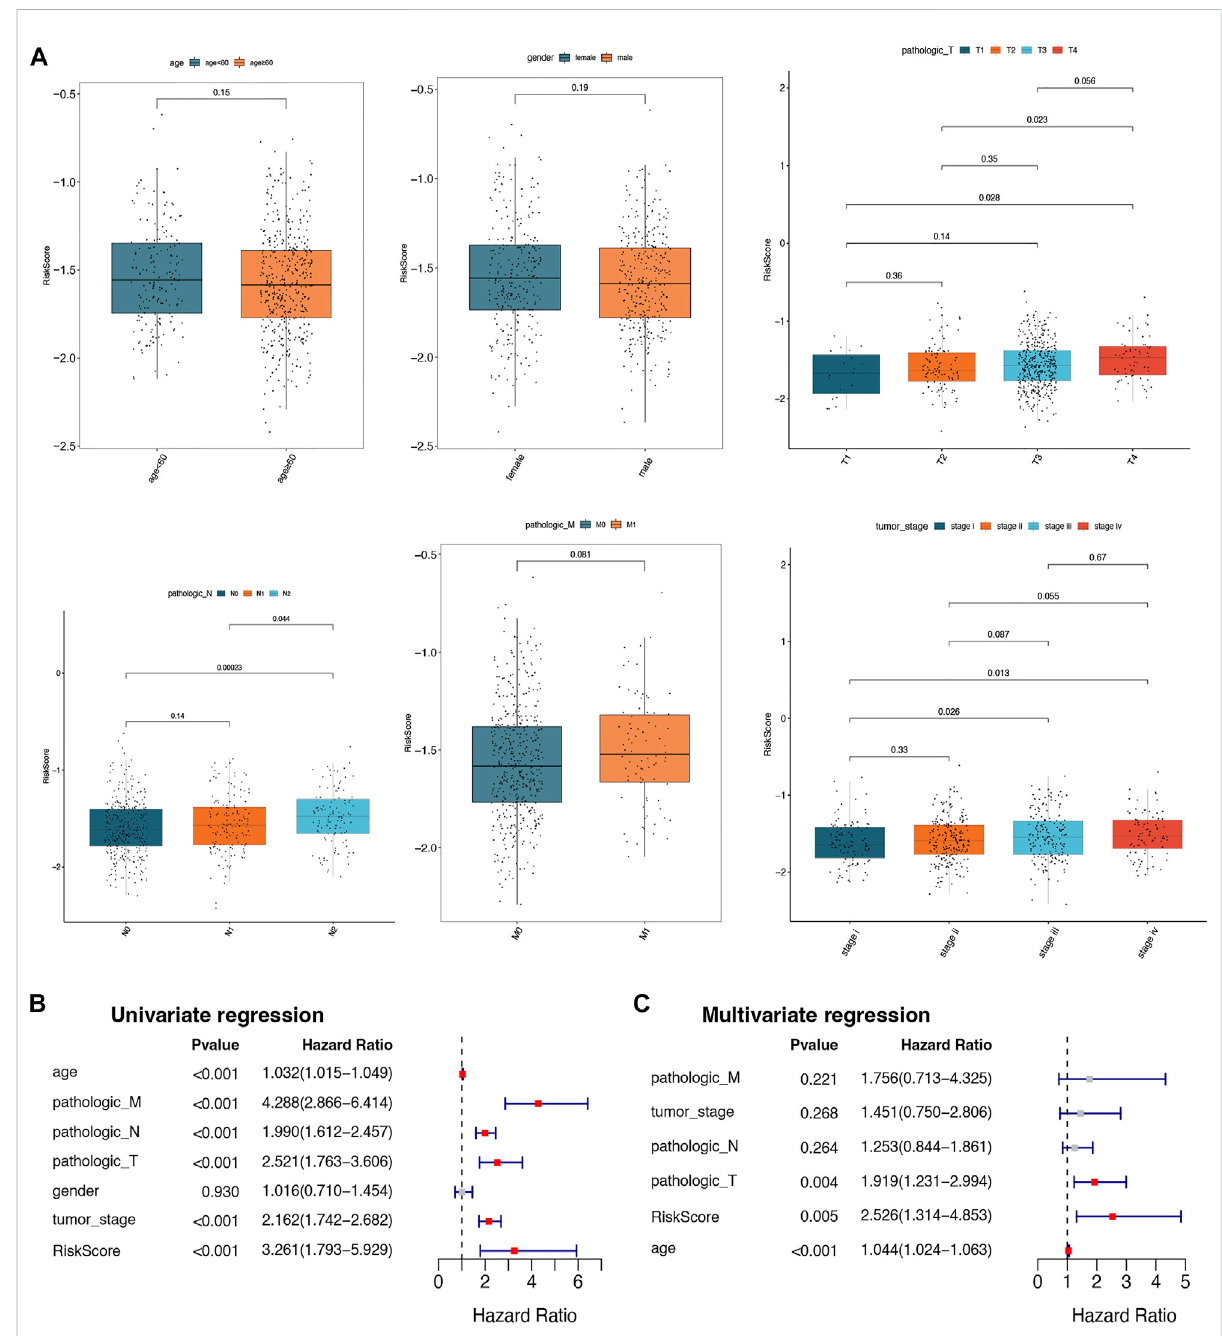
FIGURE 5 Correlation analysis between risk scores and different clinical characteristics. (A) Box plots of correlations between risk score and different characteristics (age, gender, pathologic T, pathologic N, pathologic M, and tumor stage). (B) The univariate Cox regression analysis for selected prognostic factors. (C) The multivariate Cox regression analysis for selected prognostic